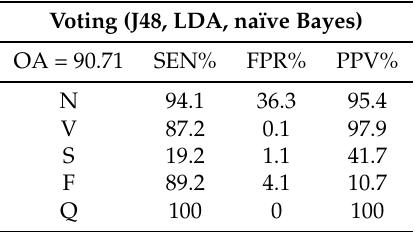
Table 9. Performance measures for combining J48, LDA, and naïve Bayes classifiers using a Voting scheme.